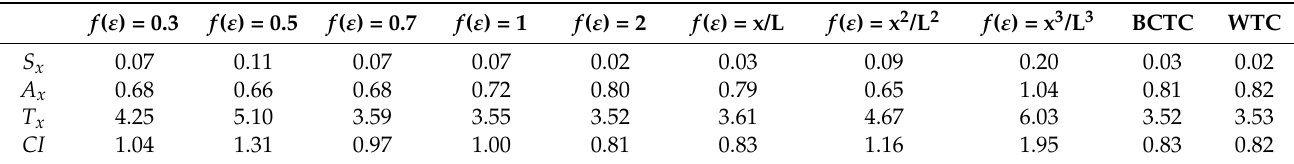
Table 1. CI for different transition curves.